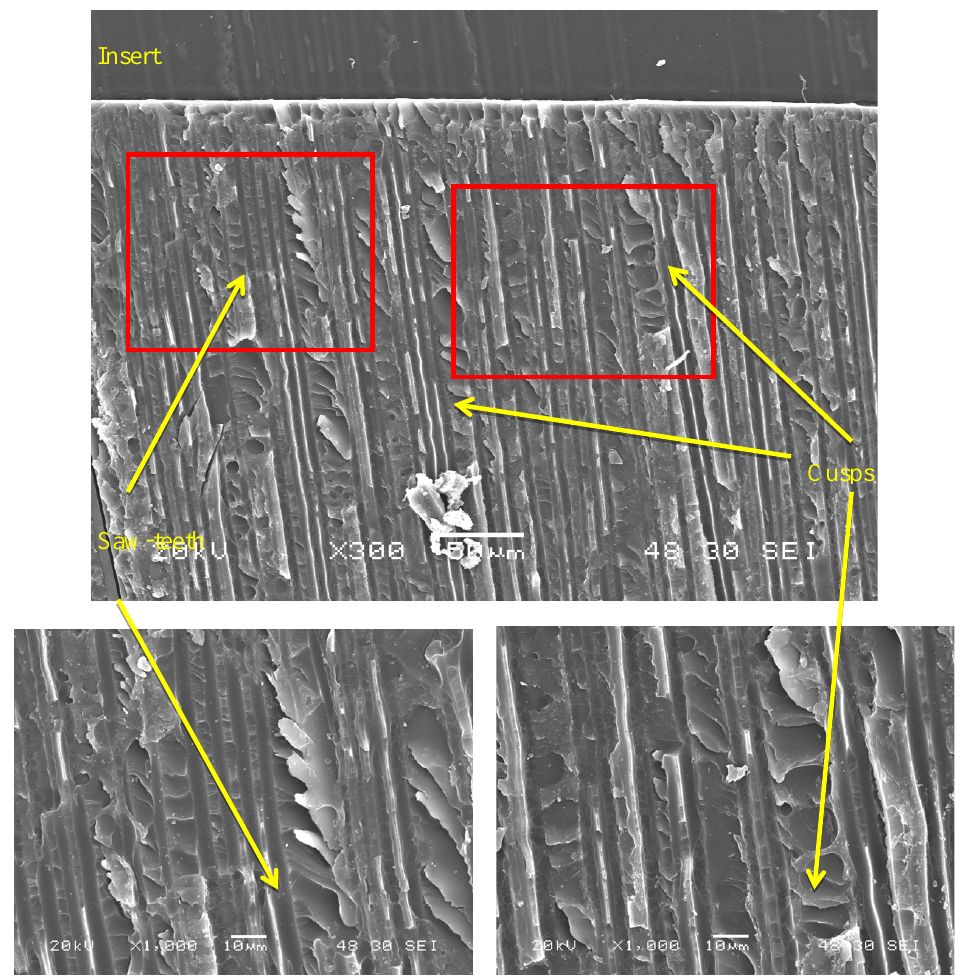
Figure 5. Presence of saw-teeth and cusps in a region near the insert.